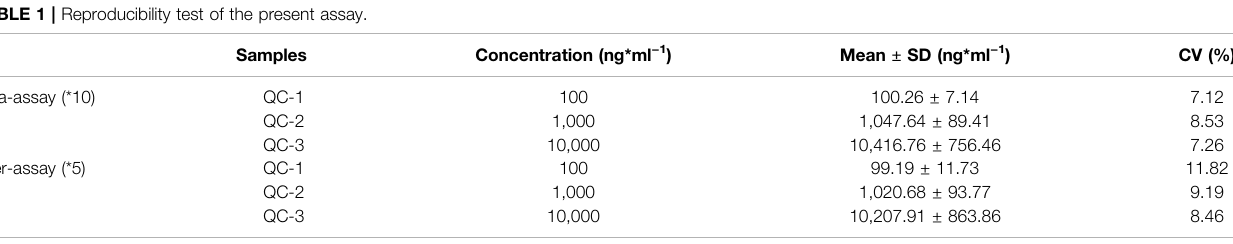
TABLE 1 | Reproducibility test of the present assay.